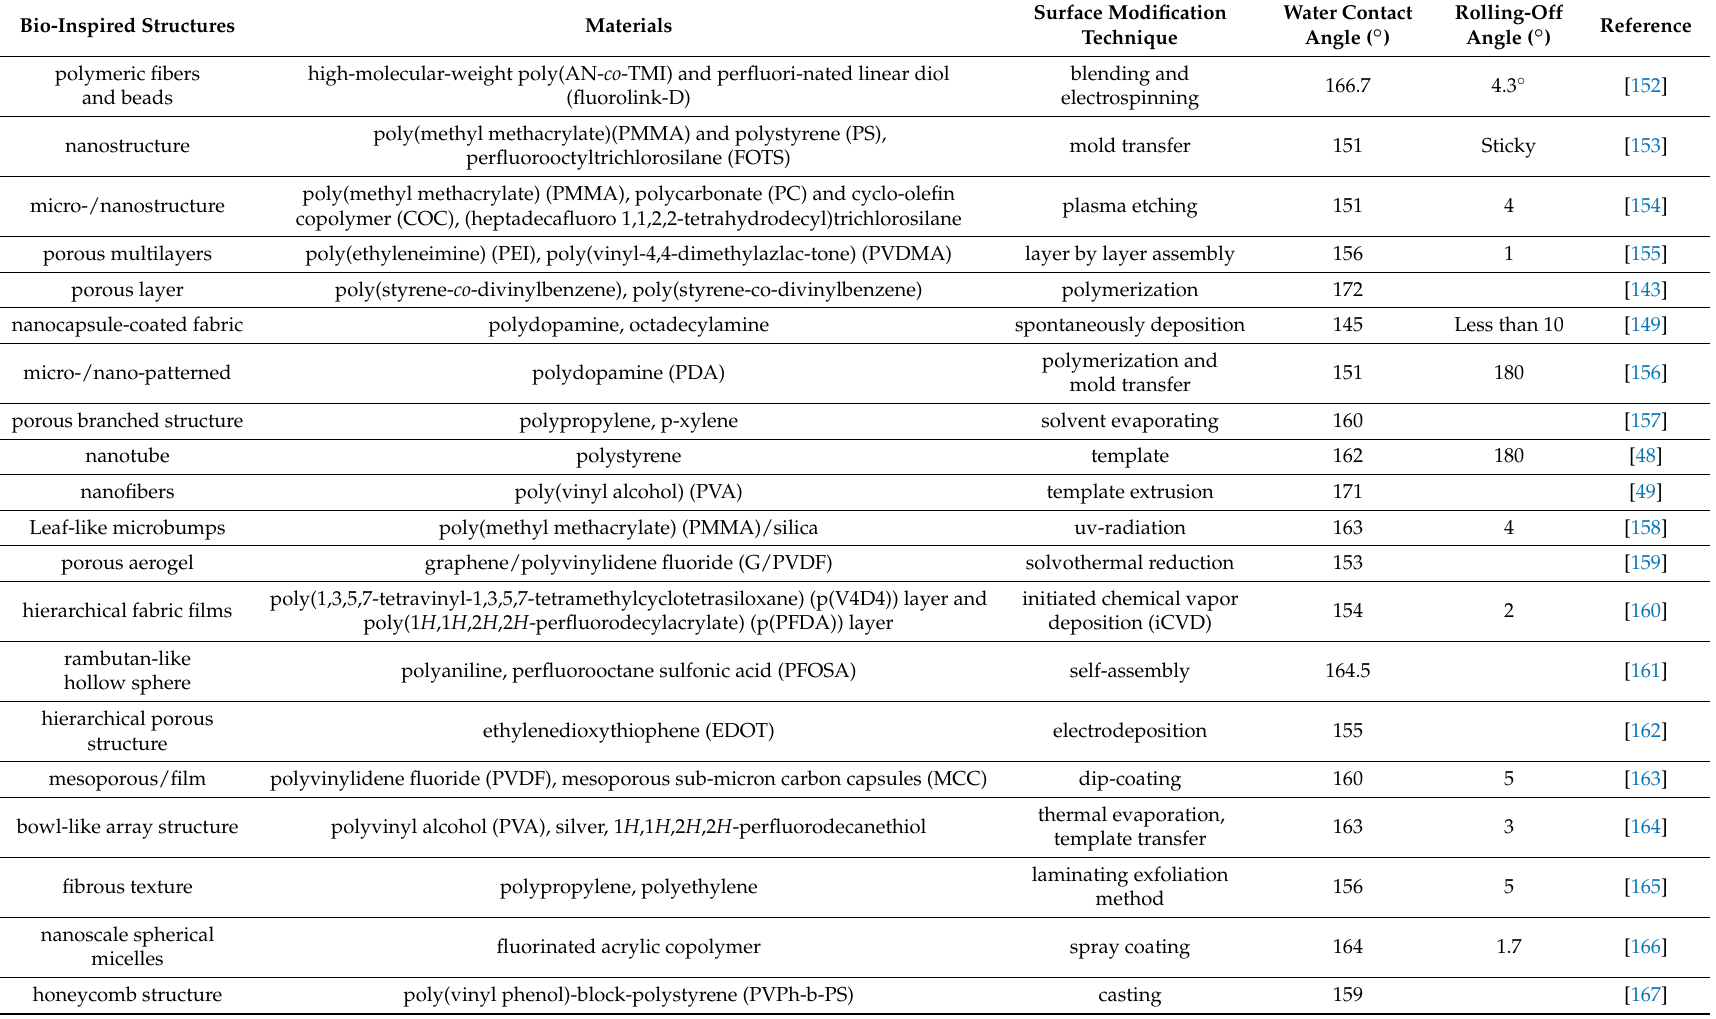
Table 2. Summary of typical structures and polymers of bio-inspired superhydrophobic